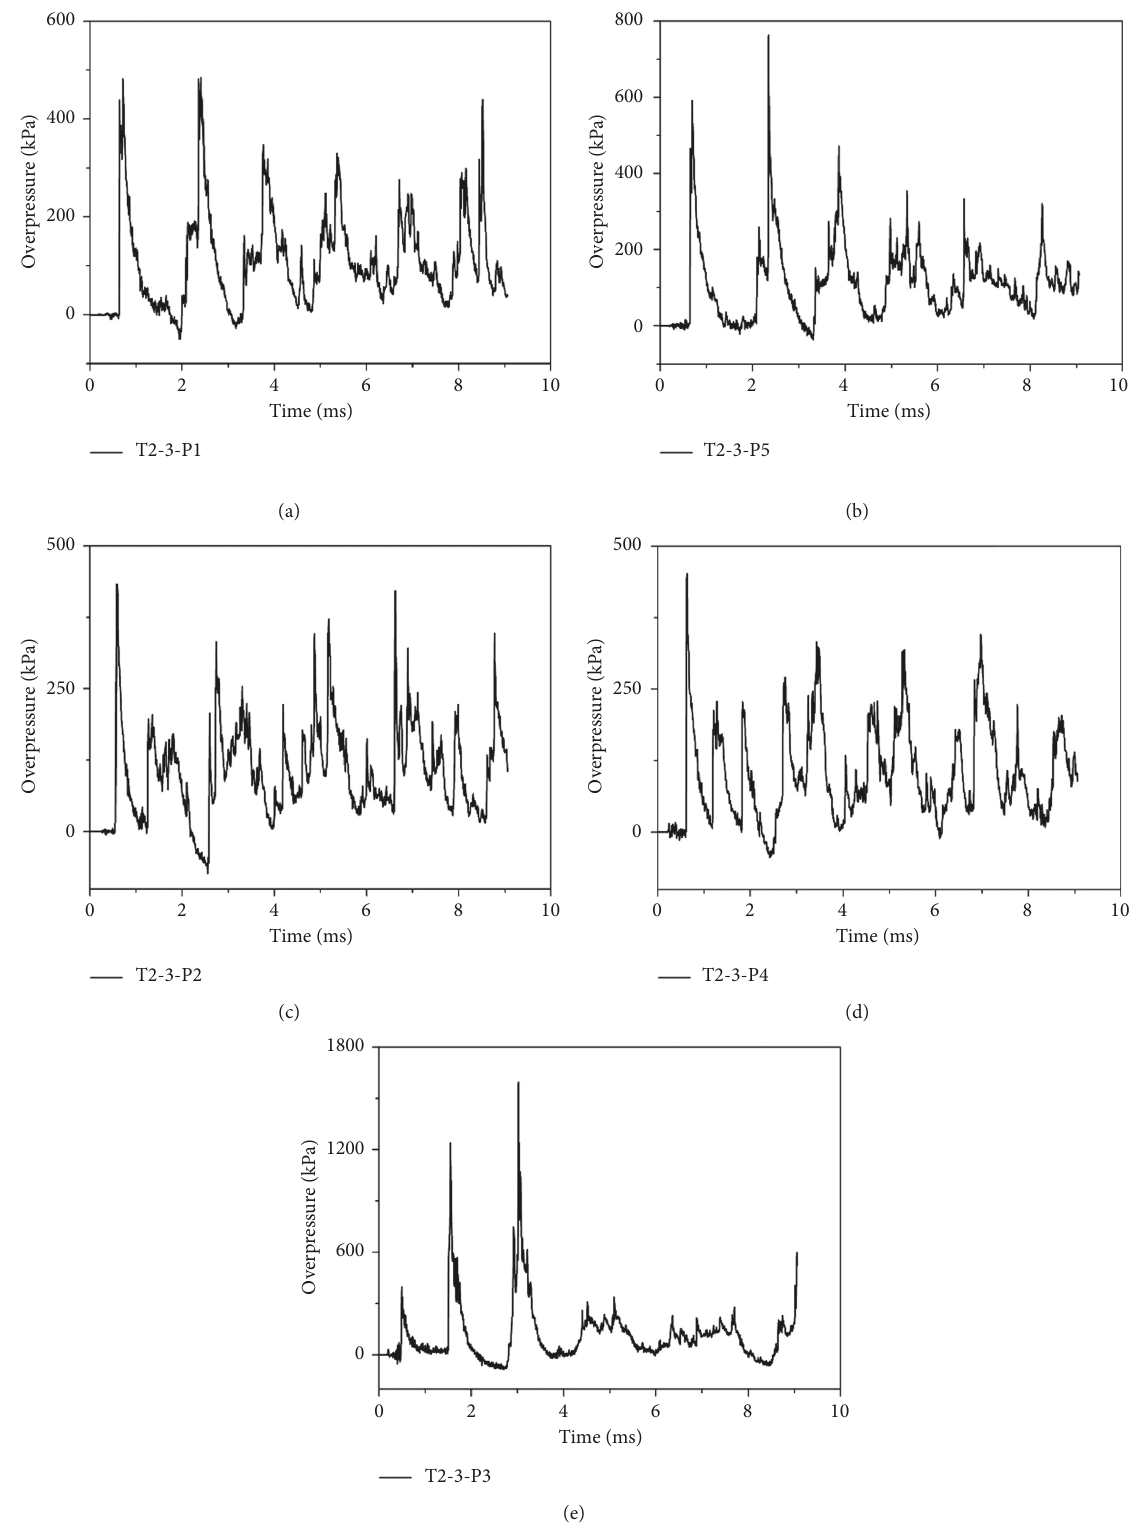
Figure 8: Experiment data from scenario T2 (12g TNT). (a) Test data from P1. (b) Test data from P5. (c) Test data from P2. (d) Test data from P4. (e) Test data from